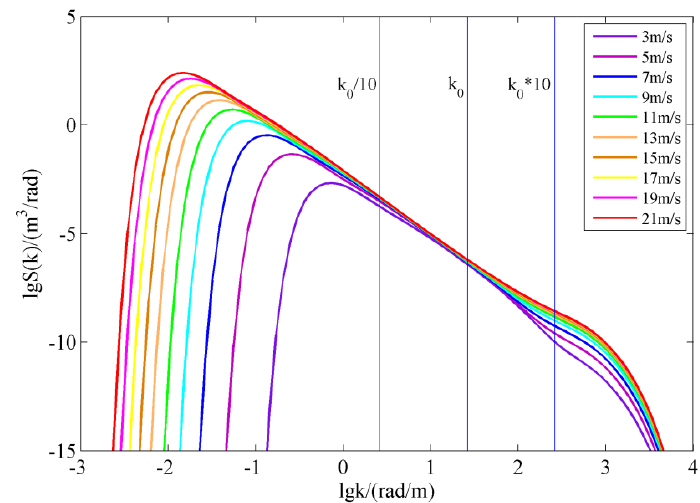
Figure 1. Apel omnidirectional spectrum in the full wavenumber range. The wind speed is from 3 to 21 m/s, with a 2 m/s interval. Here k 0 = 26.39 rad/m is a microwave wavenumber corresponding to 1.26 GHz.